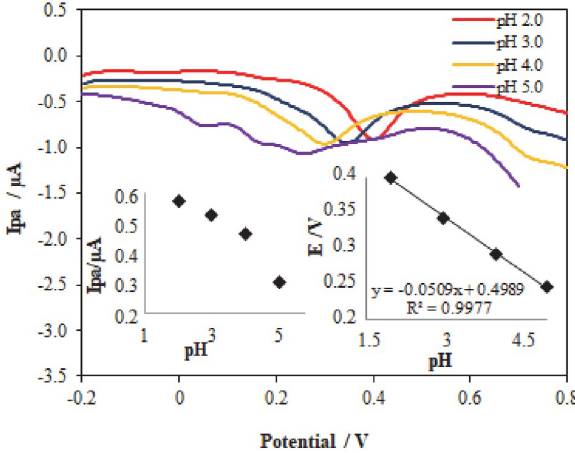
Fig. 4. CVs of 1.0 × 10 –4 molL –1 HQ at different pH values at NSC modifed electrode (Insets are the plots of pH vs E p and pH vs i p ).